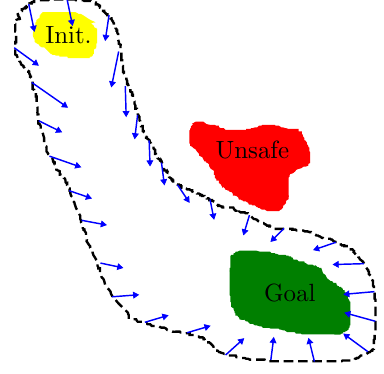
Figure 1: The set of initial states and the goal-set are subsets of a positive invariant set; whereas, the unsafe states are in its